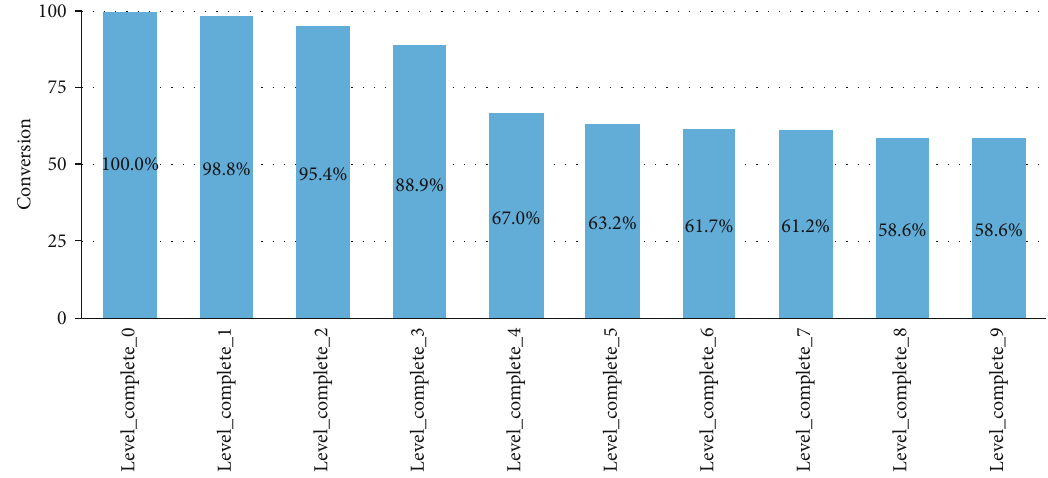
Figure 1: Level progression funnel